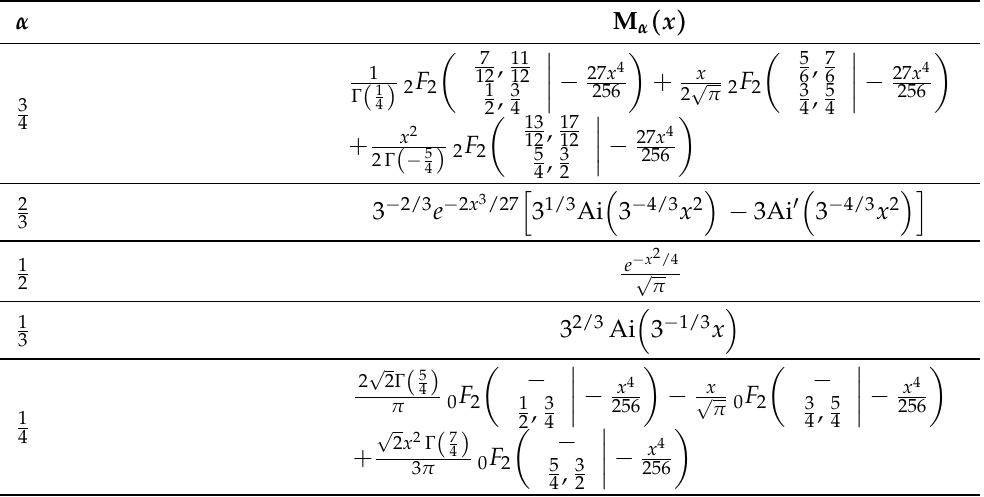
Table A16. The Mainardi function M α derived for some values of parameter α by using